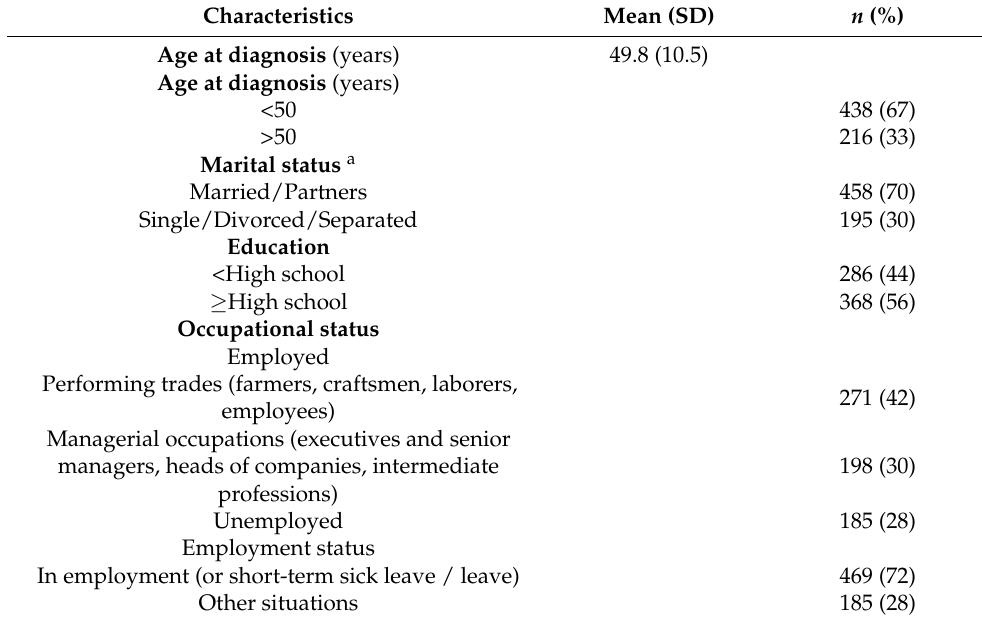
Table 1. Characteristics of the study population ( n = 654) a Missing data = 1.